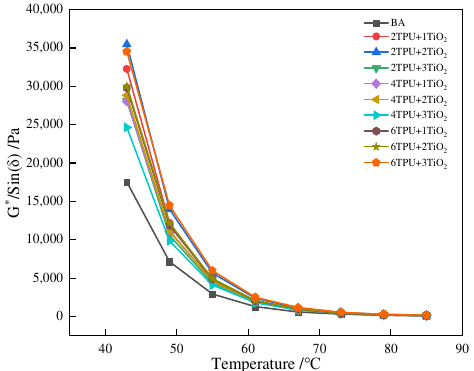
Figure 4. The curve of G*/Sinδ with temperature. It can be seen from Figure 4 that the rutting factor gradually decreases with increas- ing temperature. In the range of 43~80 °C, the rutting factor of modified asphalt was greater than that of base asphalt. This indicates that the incorporation of TPU and nano- TiO 2 improved the rutting factor of asphalt. Composite-modified asphalt has good re- sistance to rutting deformation at high temperatures. It has good high-temperature